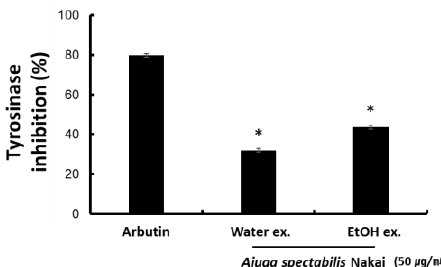
Figure 2. Effect of AS-W, AS-E on the inhibition of tyrosinase production of as measured AS-W, AS- E. Data are presented as mean ± SD. * p < 0.05 compared with control.